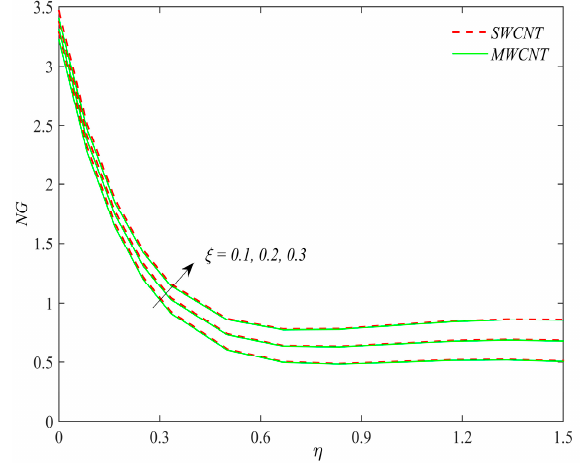
Figure 20. The variation of the entropy optimization NG for the case of SWCNT and MWCNT versus the similarity variable for the distinct values of the concentration difference parameter ξ .